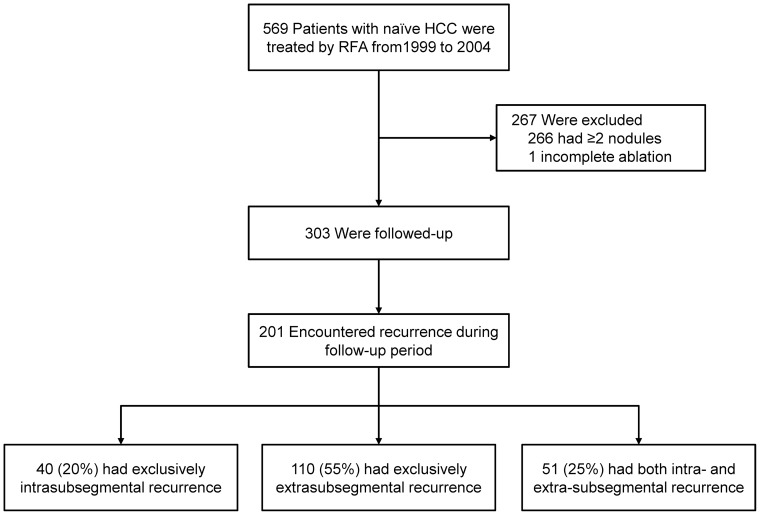
Patient enrollment flow.